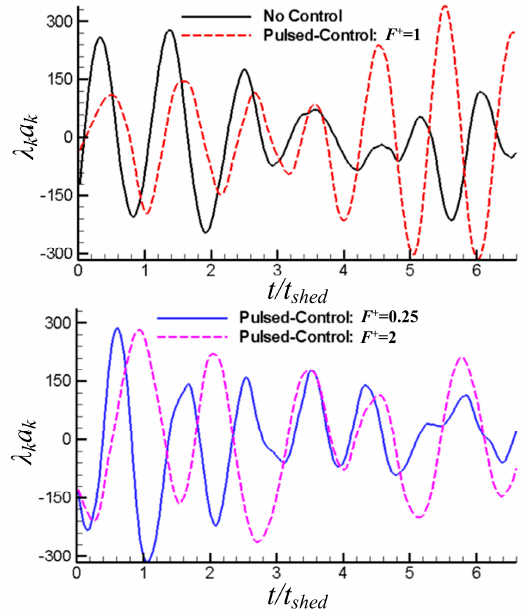
Figure 17. Evolution of the second modal coefficient with different pulsed jet frequencies.